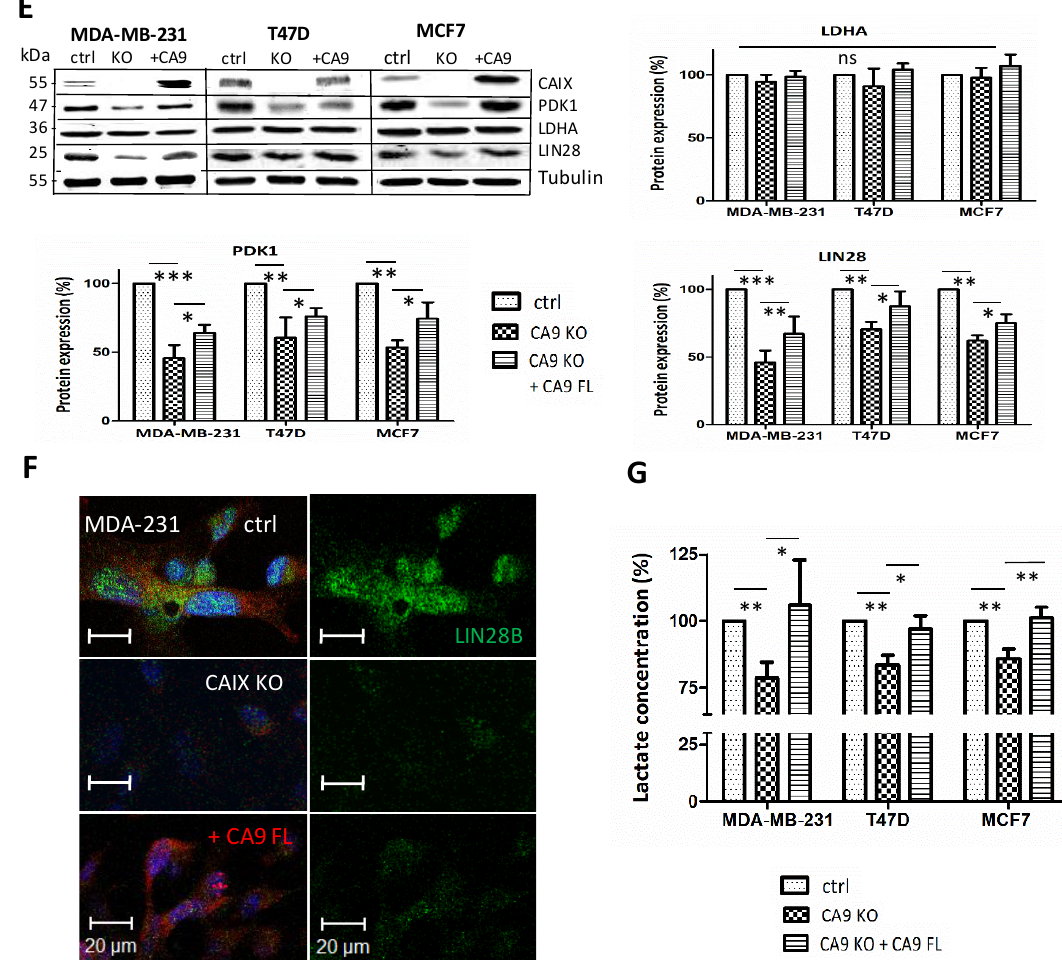
Figure 2. The effect of CAIX suppression on the glycolytic pathway. ( A ) Representative Western blot of